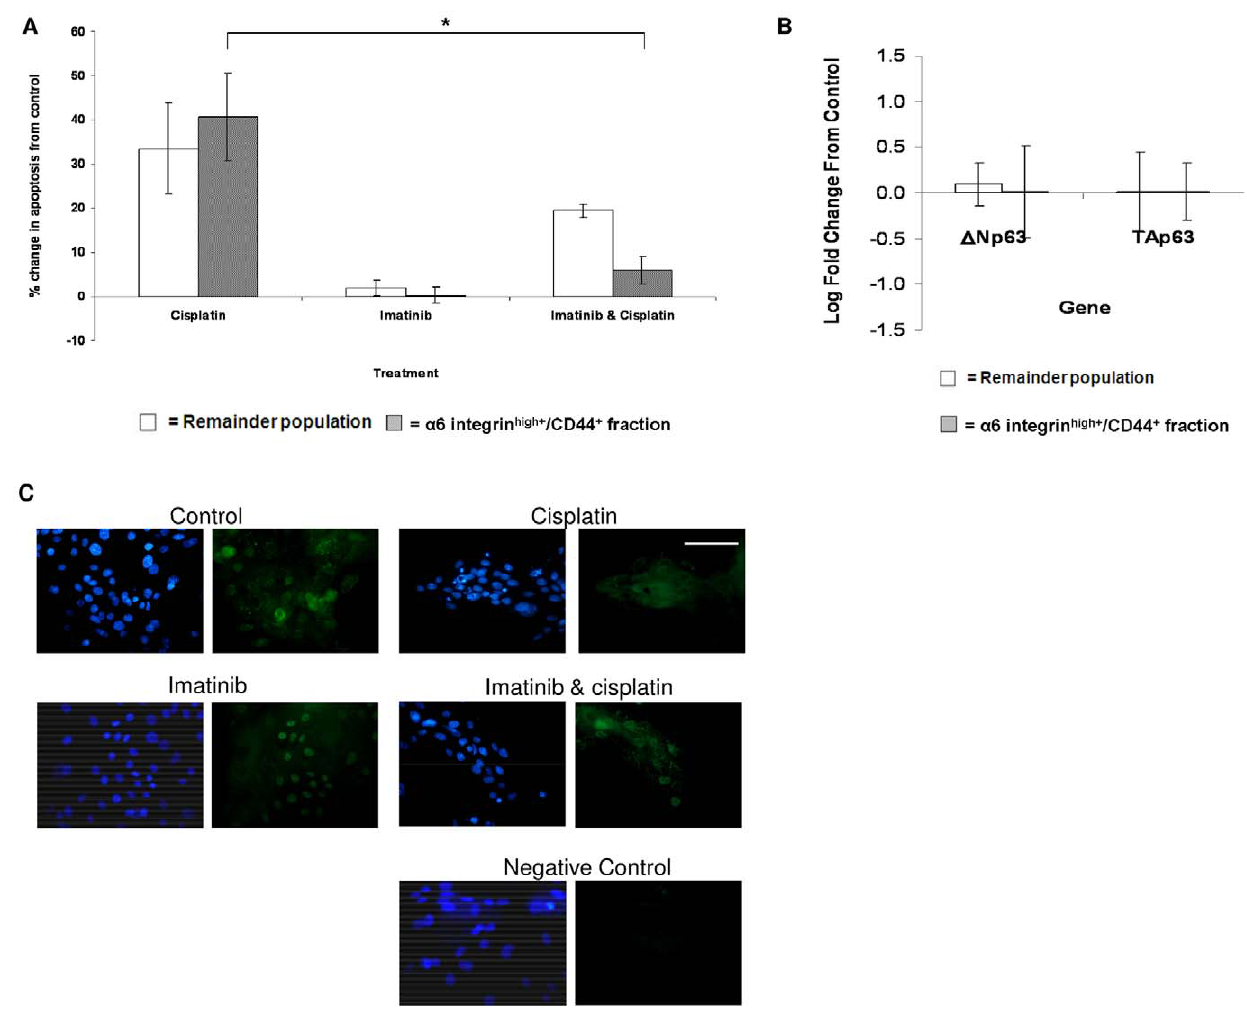
Figure 7. Effect of imatinib on keratinocyte apoptosis and p63 expression. (A) Primary keratinocytes treated with 50 m g/ml cisplatin, or 1 m M imatinib, or 1 m M imatinib for 2 hr and then 50 m g/ml cisplatin were analysed for TUNEL expression 24 hour post-treatment. TUNEL-positive cells were totalled in the a 6 integrin high + /CD44 + and remainder populations and plotted as a percentage change from control level. Data represents the mean 6 SEM where n=3. Statistical significance was determined using the paired Student’s t-test, *P , 0.05.) (B) QRT-PCR quantification of p63 gene expression in a 6 integrin high + /CD44 + and remainder keratinocyte populations 16 hr after treatment with 1 m M imatinib and 50 m g/ml cisplatin. Data represents the log mean fold change from the control (vehicle-only) for each population 6 SEM of three replicates. All results were normalised against the 28s-r-RNA housekeeping gene. Statistical significance was determined using the paired Student’s t-test (P . 0.05 in all cases). (C) FACS- separated a 6 integrin high + /CD44 + cultured keratinocytes were probed for p63 expression (green) using immunofluorescence 16 hr following treatment with 50 m g/ml cisplatin and/or 1 m M imatinib. The control cells were treated with vehicle-only and the negative control was prepared with the secondary antibody only. Nuclei were detected with DAPI (blue) and images are representative of n=2. The scale bar is equal to 100 m